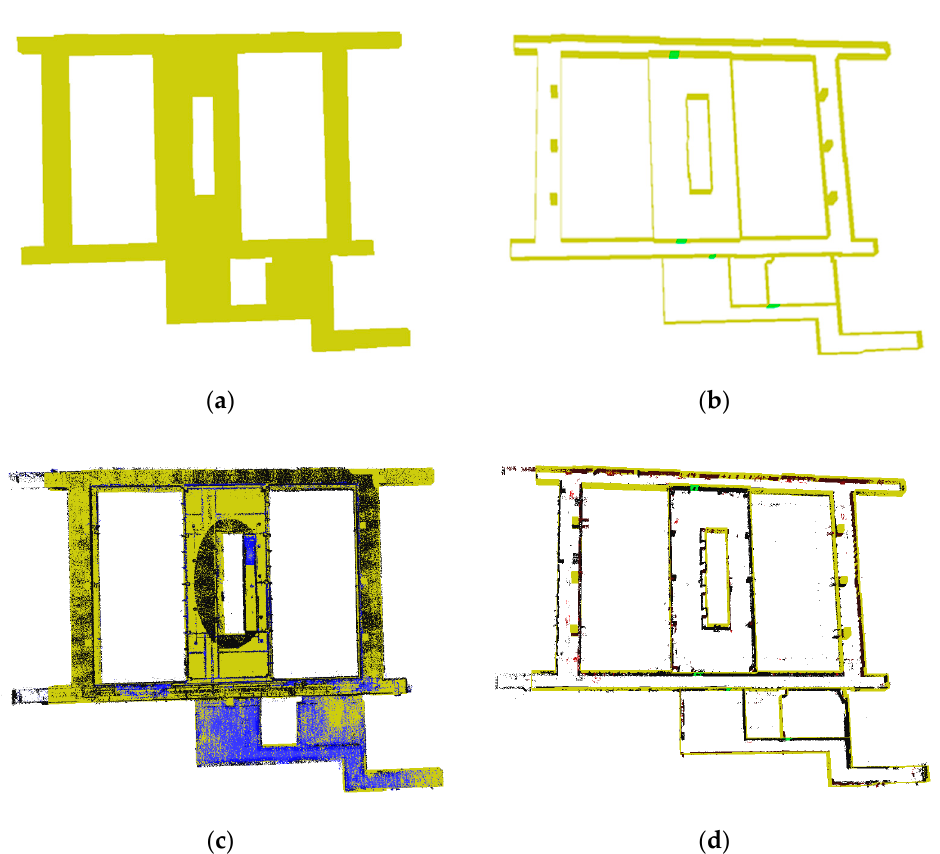
Figure 18. Structural model results of the corridor at the Shenzhen University. ( a ) The structural model. ( b ) Vector model of walls and pillars. ( c ) Matching between point clouds and the structural model. ( d ) Matching between point clouds and vector model of walls and pillars.